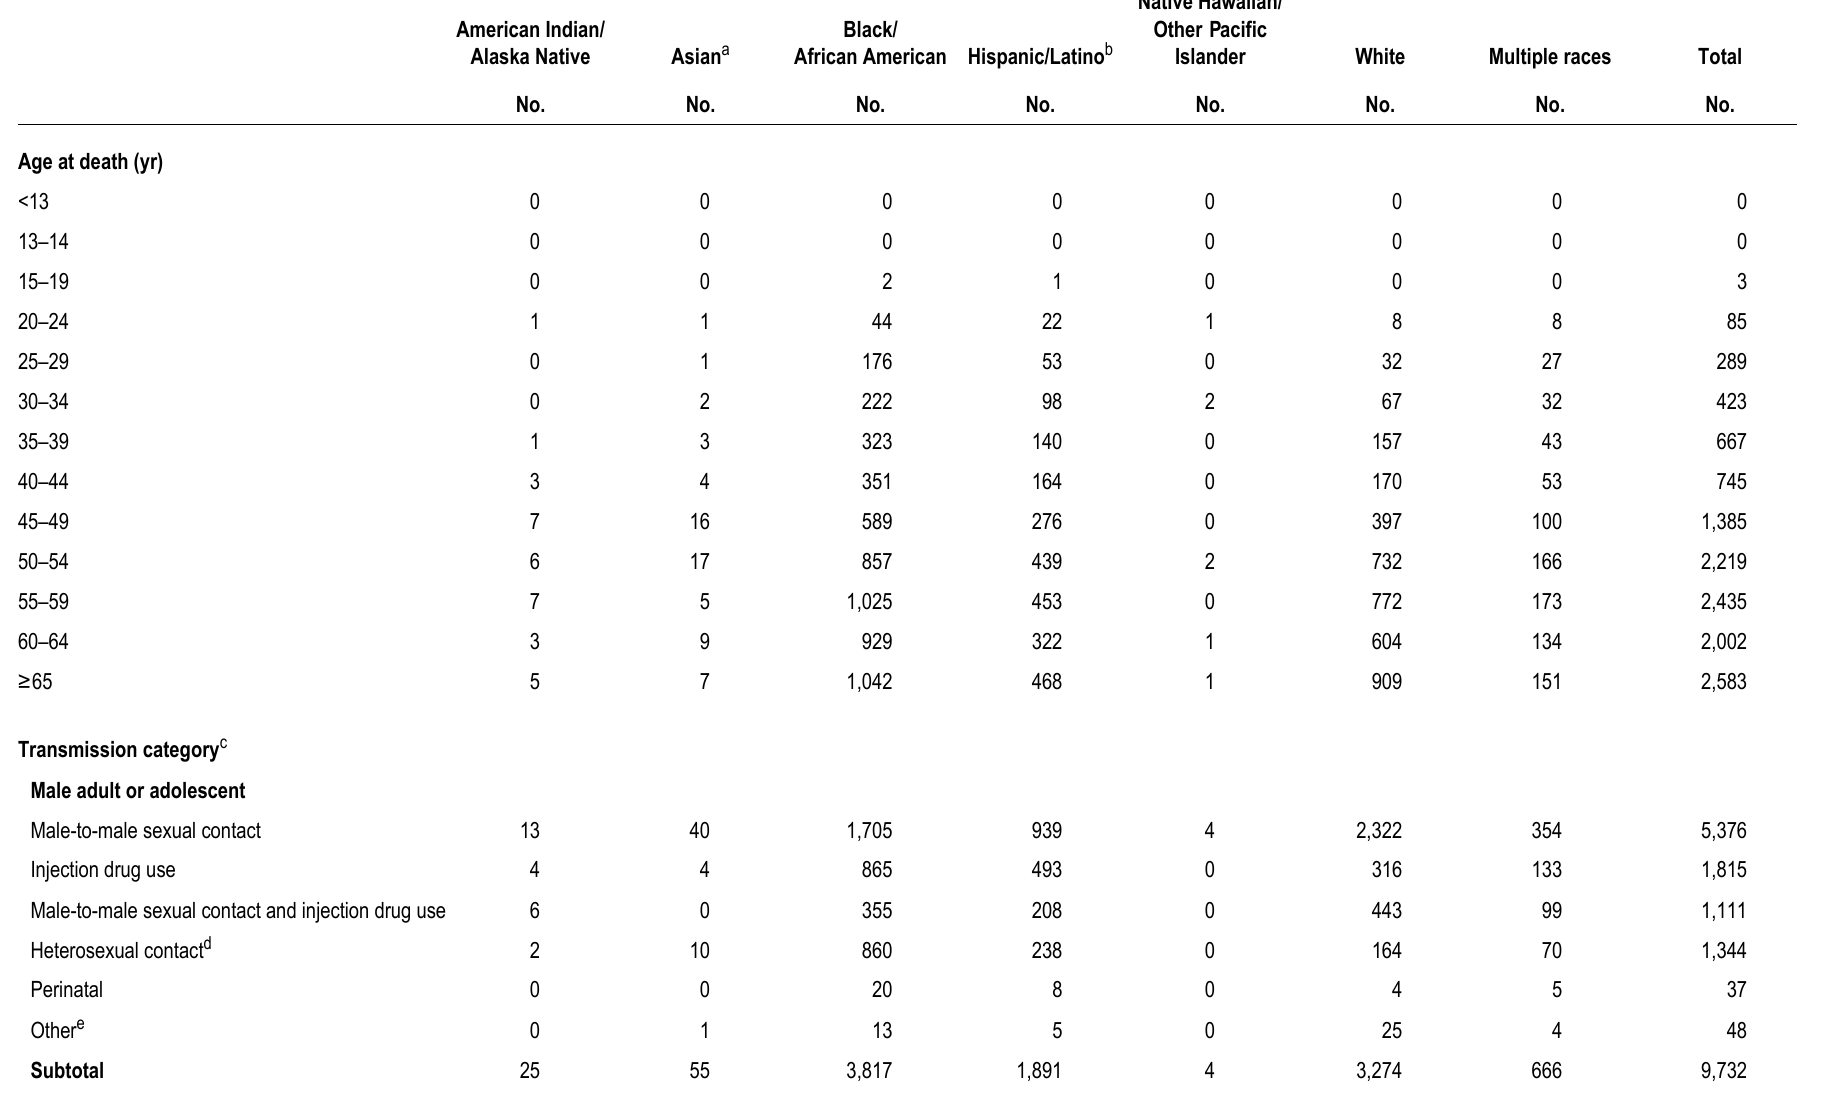
Table 21b. Deaths of persons with diagnosed HIV infection ever classified as stage 3 (AIDS), by race/ethnicity and selected characteristics, 2017—United States and 6 dependent areas Native Hawaiian/ American Indian/ Black/ Other Pacific Alaska Native Asian a African American Hispanic/Latino b Islander White Multiple races Total No. No. No. No. No. No. No.